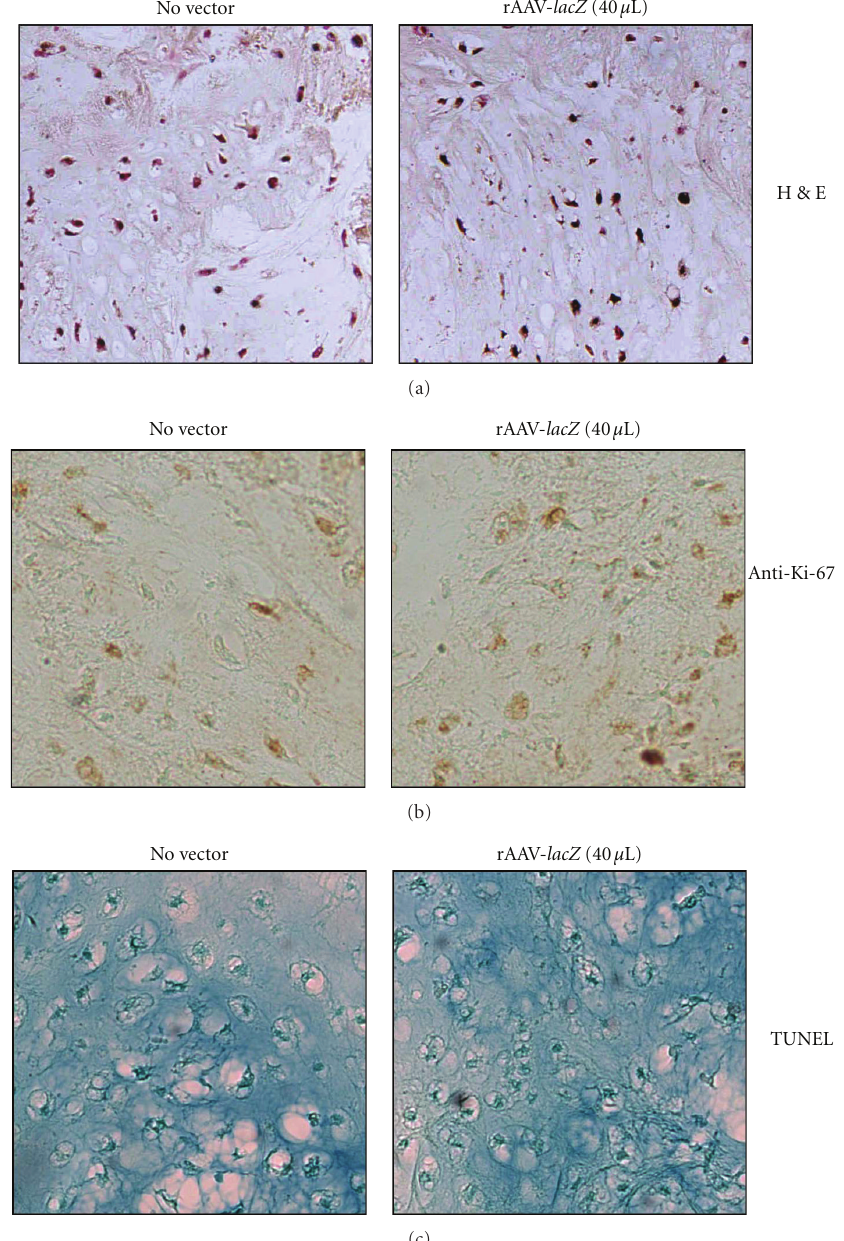
Figure 4: E ff ects of rAAV-mediated gene transfer on the survival of transduced primary human chondrosarcoma in situ . Human chondrosarcoma explant cultures were transduced with rAAV- lacZ (40 μ L) or let untreated and processed after 20 days for H&E staining (a), immunodetection of Ki-67 (b), and TUNEL assay (c). All at magnification × 20 except for H&E staining (magnification ×